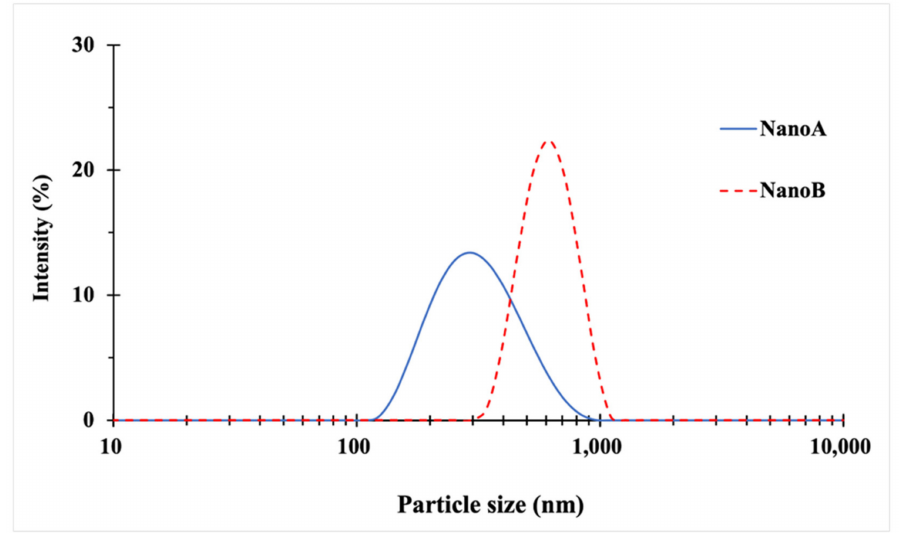
Figure 1. Hydrodynamic particle sizes of the representative batch of NanoA and NanoB suspension after the preparation obtained by DLS.